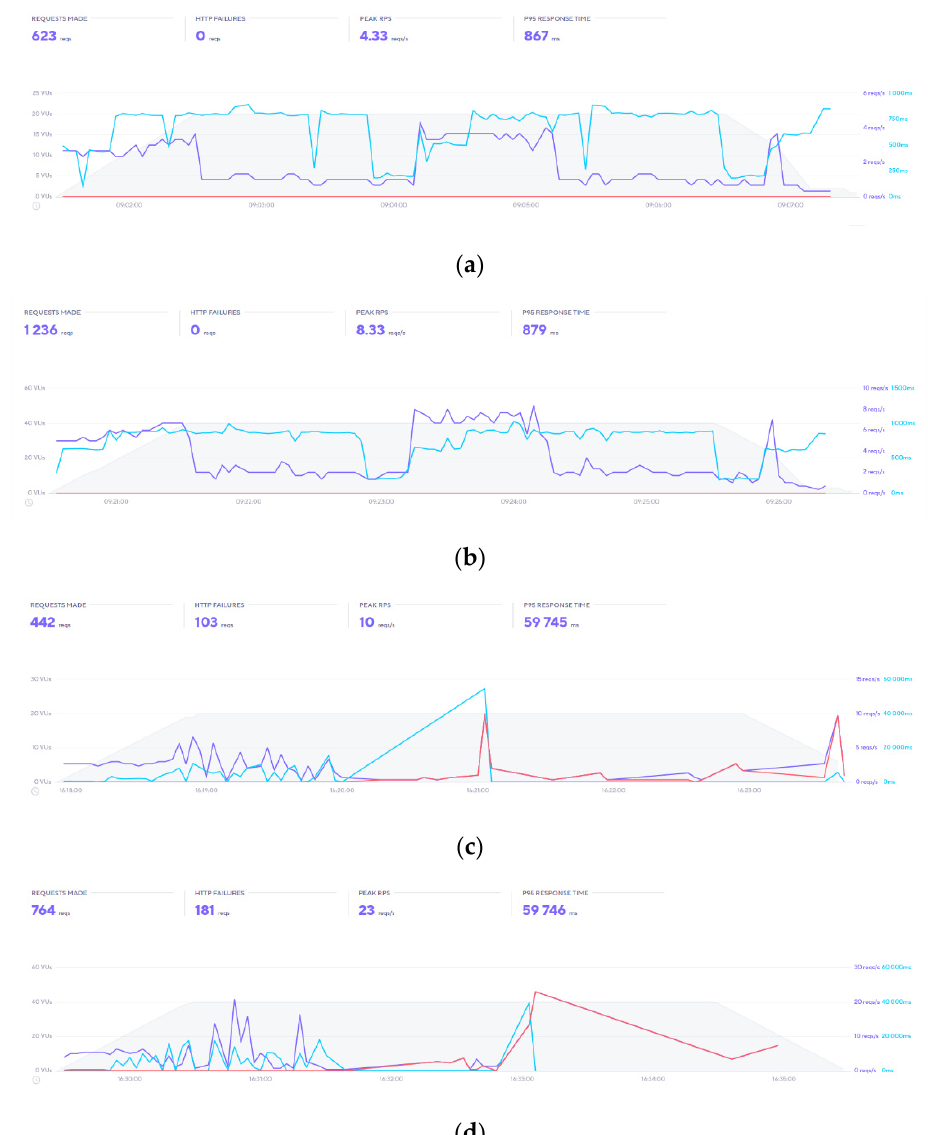
Figure 10. Graphs with the performance of the tests as produced with the tool K6, where: ( a ) Test